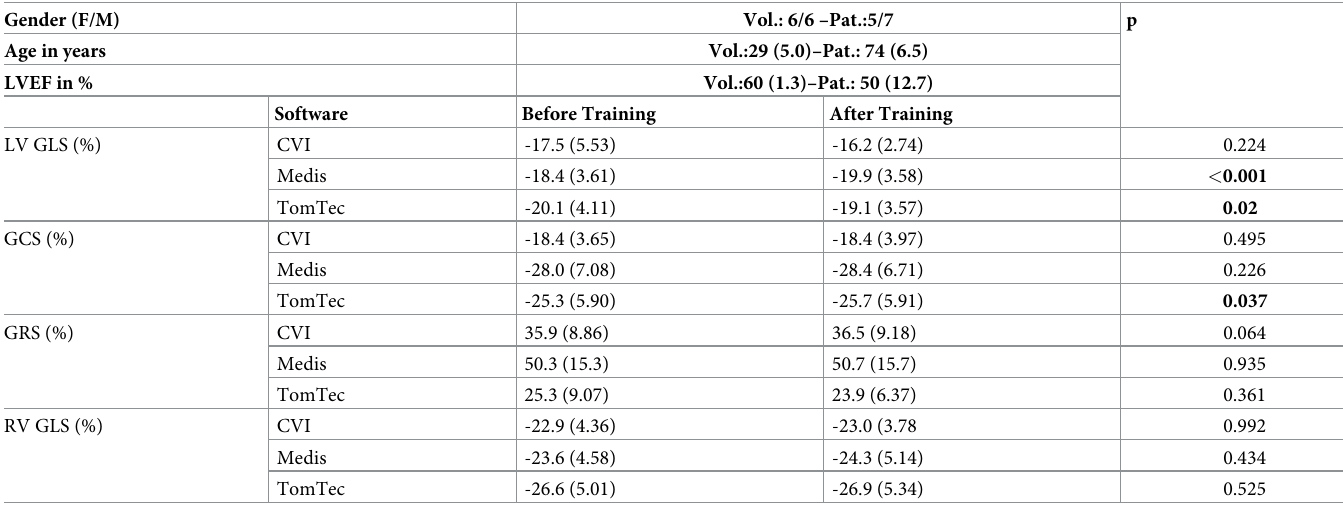
Table 1. Patients demographics and